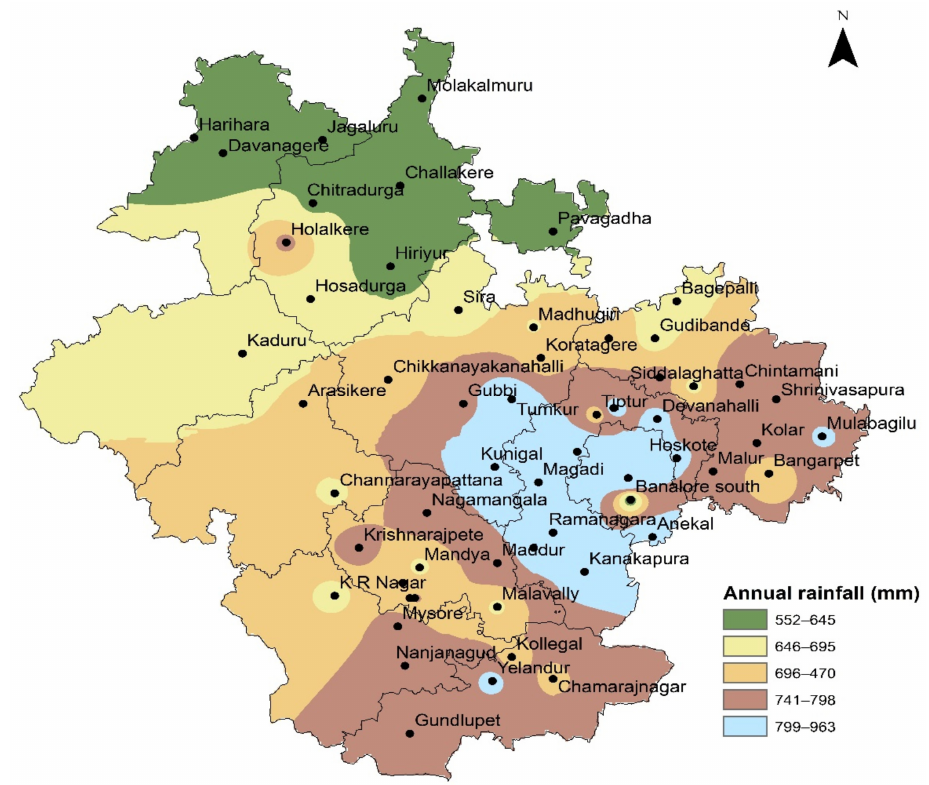
Figure 2. Spatial variability of rainfall over the study area (annual rainfall average of 60 years,